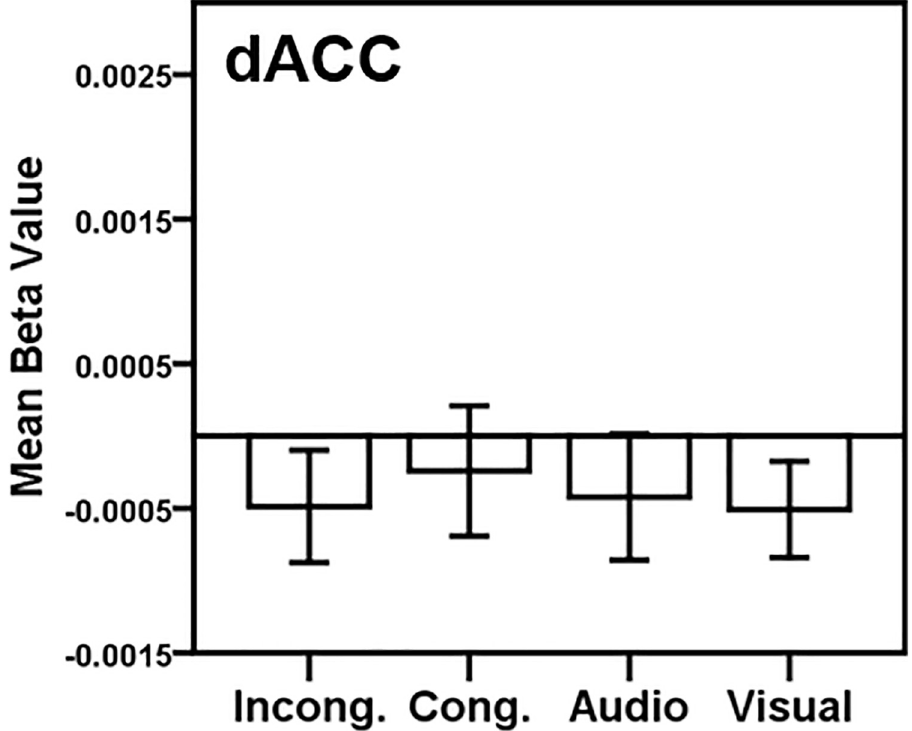
Fig 9. Dorsal anterior cingulate cortex ROI analysis. A region of interest (ROI) was generated from a 10 mm sphere [center Talairach coordinates 3–22 43]. Activation within the ROI is plotted for each condition > rest. Key: dACC = Dorsal anterior cingulate cortex. Conditions: Incong. = Incongruent; Cong. = Congruent; Audio = Audio- only; Visual = Visual-only. Error bars represent ± 1 standard error of the mean.